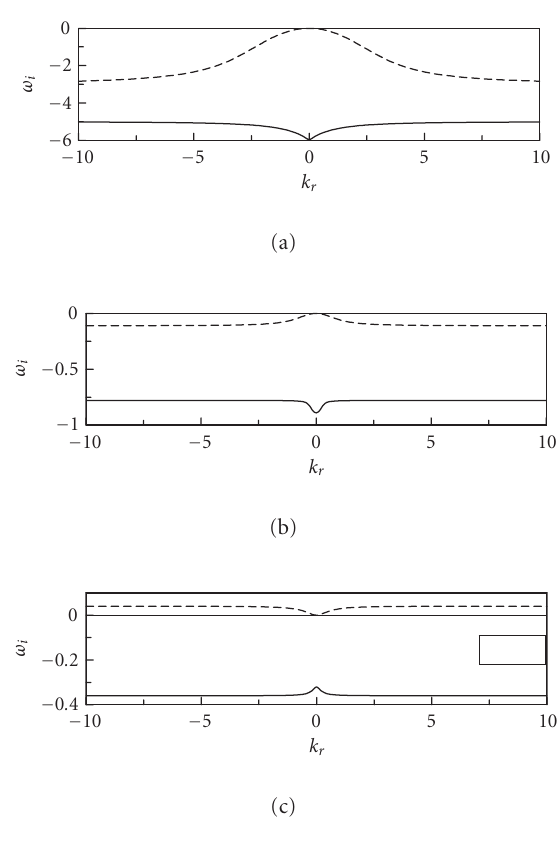
Figure 3.1. Imaginary part of temporal branches, where in (a) F = 0 . 5, in (b) F = 1 . 5, and in (c) F = 2 .